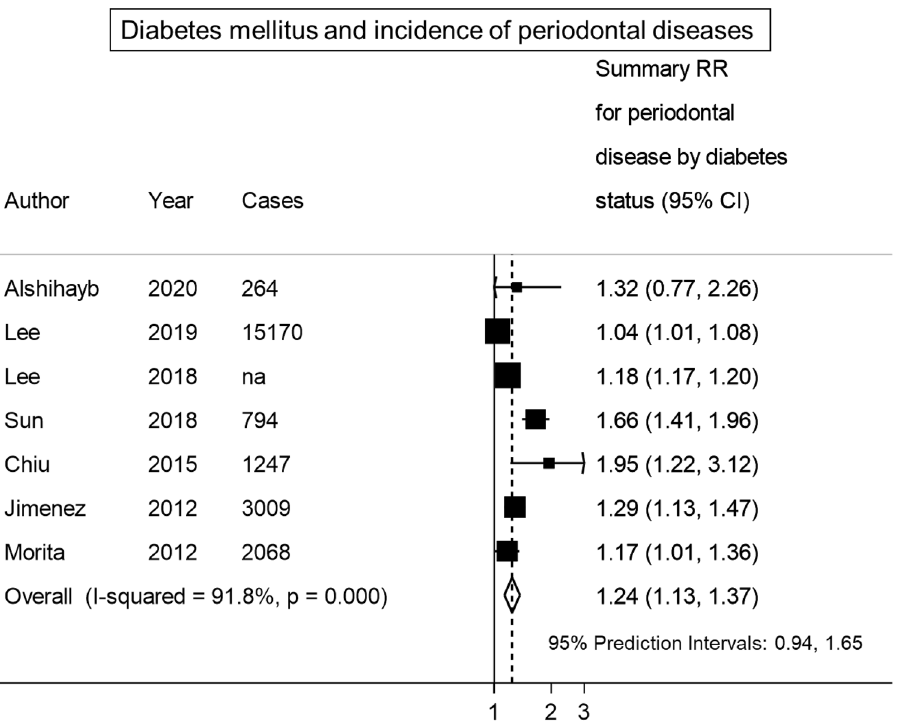
Figure 3. Meta-analysis of diabetes mellitus and incidence of periodontal